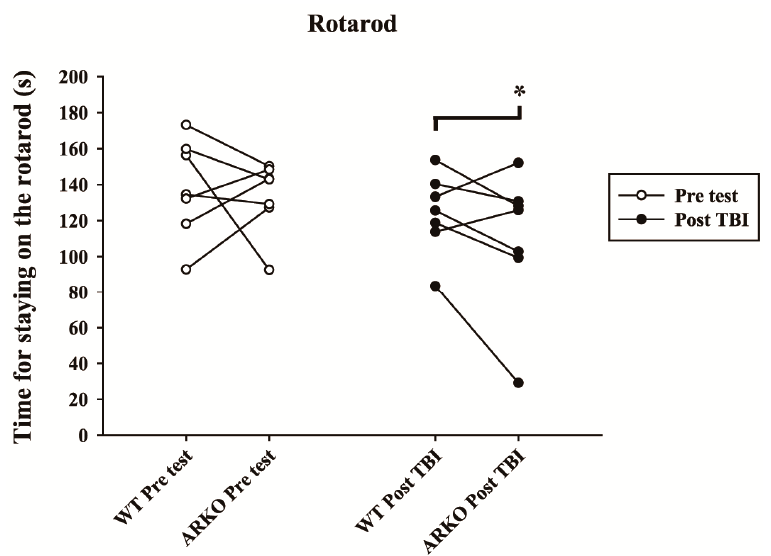
Figure 5. Androgen receptor knockout significantly decreases the motor function of mice after TBI. The time during which the mice stayed on the rod at an accelerating speed was evaluated before (pre) and 20 days after TBI (post). The white circles represent the rotarod test before TBI, and the black circles represent rotarod results in the WT and ARKO group after TBI. Each circle shows the mean of five trials of the rotarod test. The data points of each pair of littermates are connected by a line. Compared with the WT, the time spent on the rod shows a significant difference in the ARKO mice following TBI. All data are presented as the mean with paired t-test; * p < 0.05 versus wild-type; n = 7 in each group.